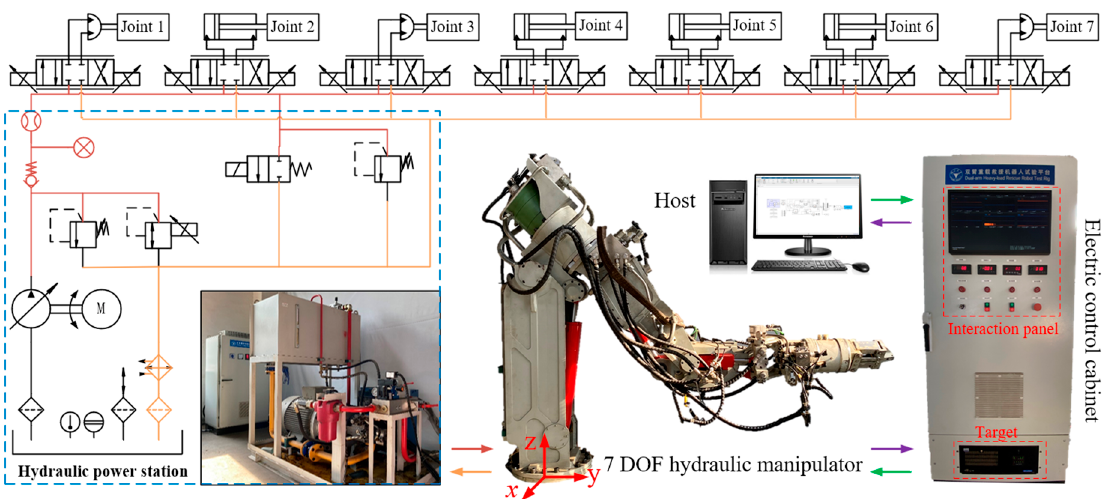
Figure 6. System diagram of 7-DOF hydraulic manipulator experimental platform.